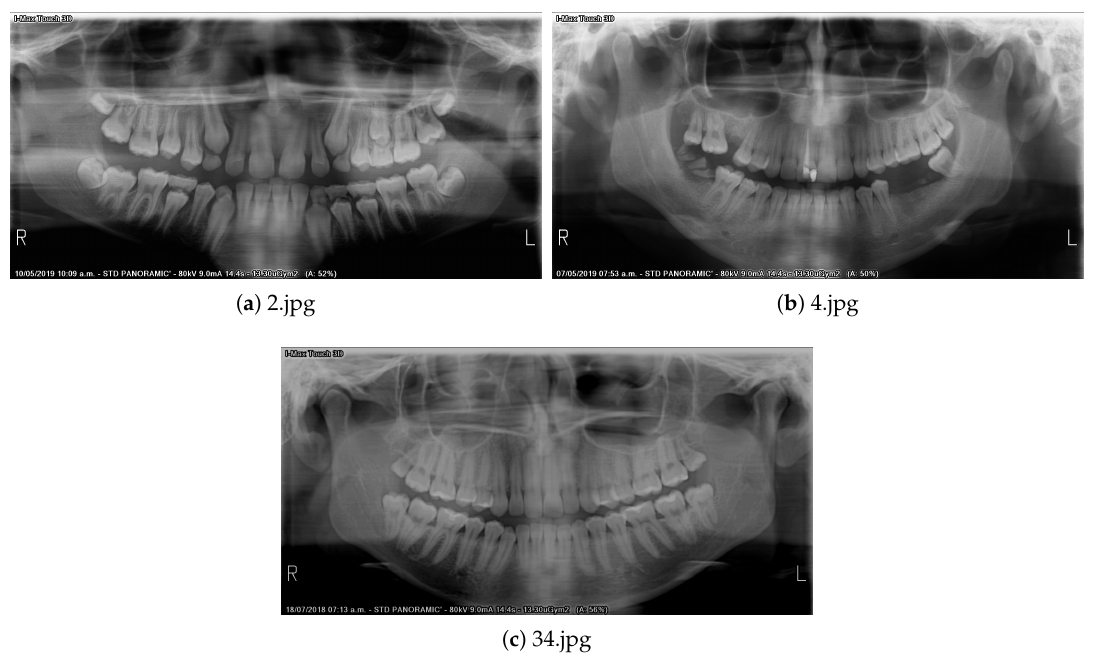
Figure 1. Example panoramic radiographs: ( a ) mixed dentition; ( b ) partially edentulous permanent dentition; and ( c ) complete permanent